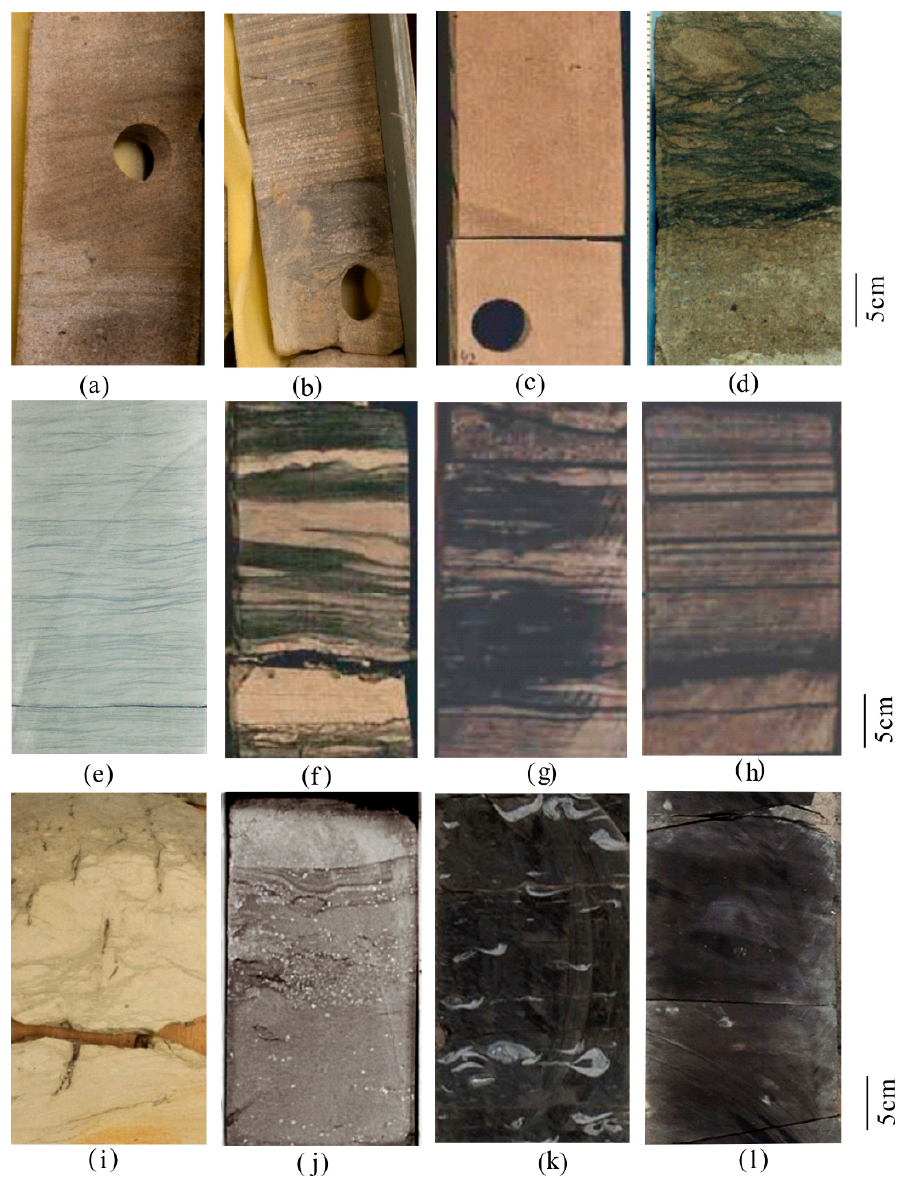
Figure 4. Depositional structures of sandbar reservoir samples from the southern Indus basin. ( a ) Fine sandstone, cross-bedding (center bar); ( b ) Medium sandstone, parallel bedding, interbedded with thin shell fragments (center bar); ( c ) Medium sandstone, massive bedding (center bar); ( d ) Fine sandstone, massive bedding (containing mud and gravel) at the bottom and storm cross bedding at the top; ( e ) Siltstone, wavy cross-bedding (bar edge); ( f ) Siltstone, lenticular bedding (bar edge); ( g ) Argillaceous siltstone, flattened bedding (bar edge); ( h ) Argillaceous siltstone, horizontal bedding (bar edge); ( i ) argillaceous siltstone, vertical cave (bar edge); ( j ) silty mudstone, biodisturbance phenomenon: mass and partial laminar deformation (inter bar); ( k ) silty mudstone, highly calcified and rich in biological shells (inter bar); ( l ) dark black and massive mudstone (mudstone).